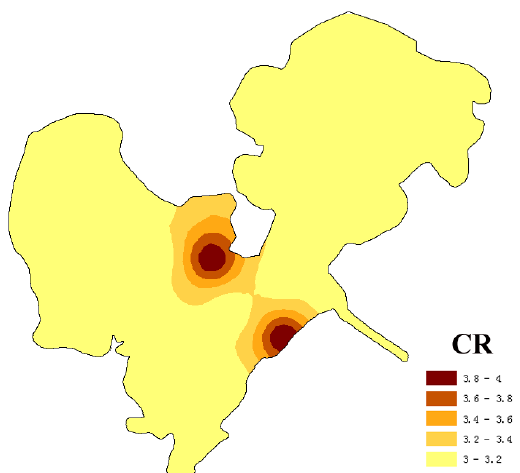
Figure 3. Integrated carcinogenic risk levels based on certainty assessment of surface water from Honghu Lake.